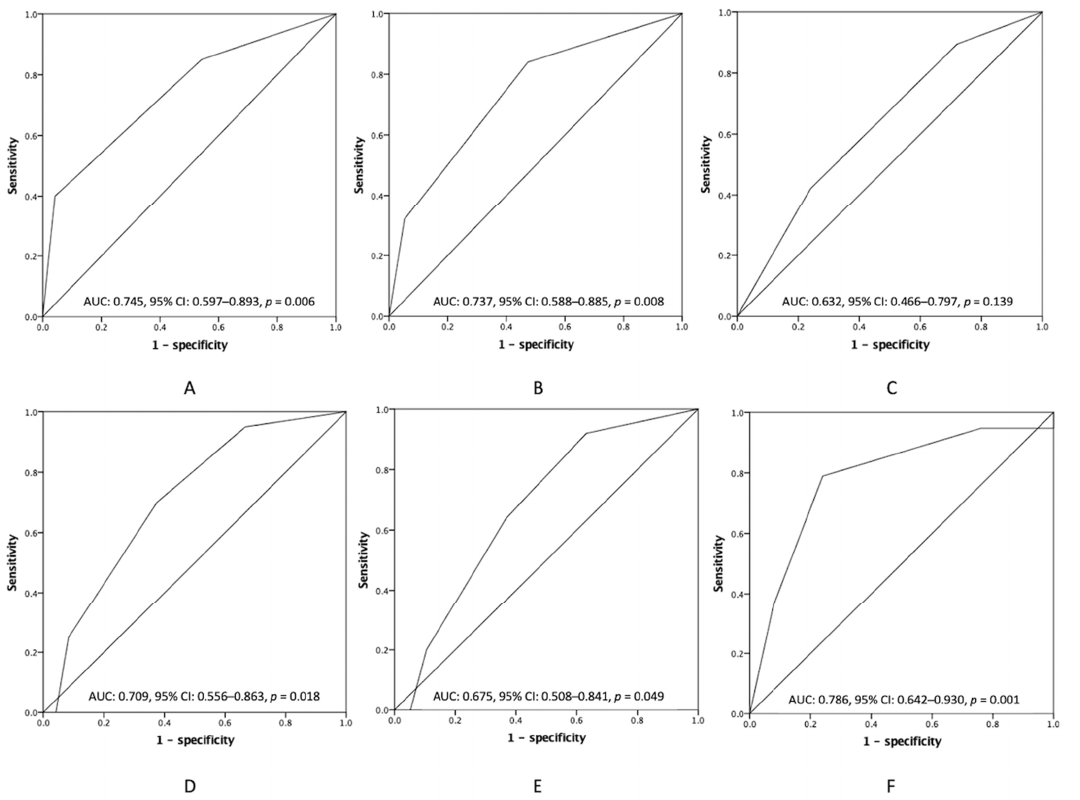
Figure 5. ROC curve analyses were used to examine predictive values of ( A ) postoperative 6-month mortality, ( B ) postoperative 12-month mortality, and ( C ) incomplete cytoreduction of the combination of an emerging number of CT risks and NLR, and predictive values of ( D ) postoperative 6-month mortality, ( E ) postoperative 12-month mortality, and ( F ) incomplete cytoreduction of the PCI class for GCPC patients receiving CRS-HIPEC. ROC, Receiver operating characteristic; CT, computed tomography; NLR, neutrophil-to-lymphocyte ratio; PCI, peritoneal cancer index; GCPC, gastric cancer-associated peritoneal carcinomatosis; CRS-HIPEC, cytoreductive surgery and hyperthermic intraperitoneal chemotherapy.